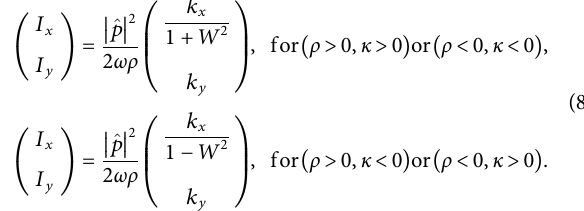
FIGURE 1 (A) Schematic representationofdirectionsofthecoupling vector andwave vector intheWillisacousticmedium. (B) Particle motion ofaplane wave in the Willis acoustic medium. (C) Slowness curve of the positive or double negative Willis medium, k 0 (cid:2) ω velocityofthemediumwith ρ > 0and κ > 0,andtheredarrowsdenotethegroupvelocityofthemediumwith ρ < 0and κ < 0. (D) Slownesscurveofasingle (cid:7)(cid:7)(cid:7)(cid:7) − ρ / κ negativeWillismedium, k 0 (cid:2) ω